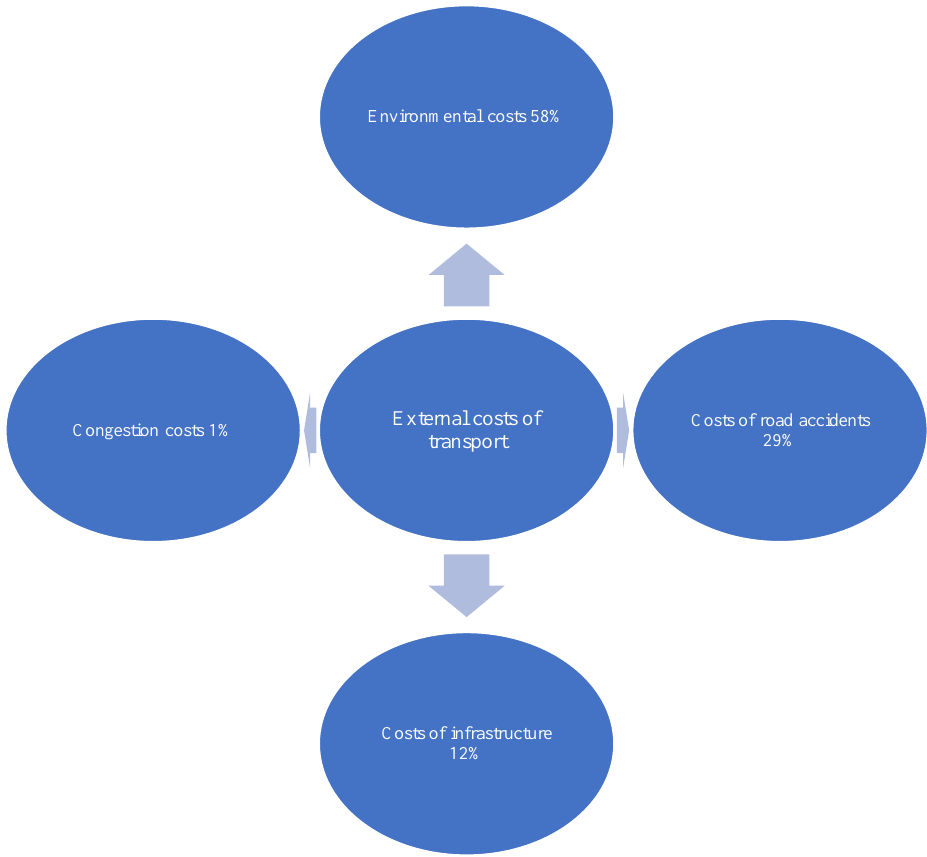
Figure 2. Categories of external costs of road transport. Source: own study based on